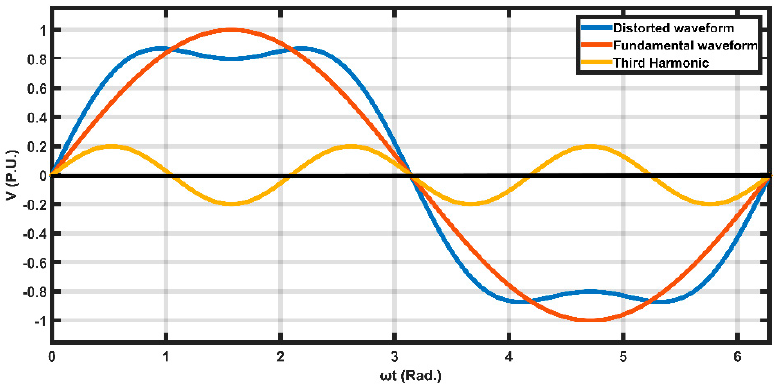
Figure 1. First and third harmonics.